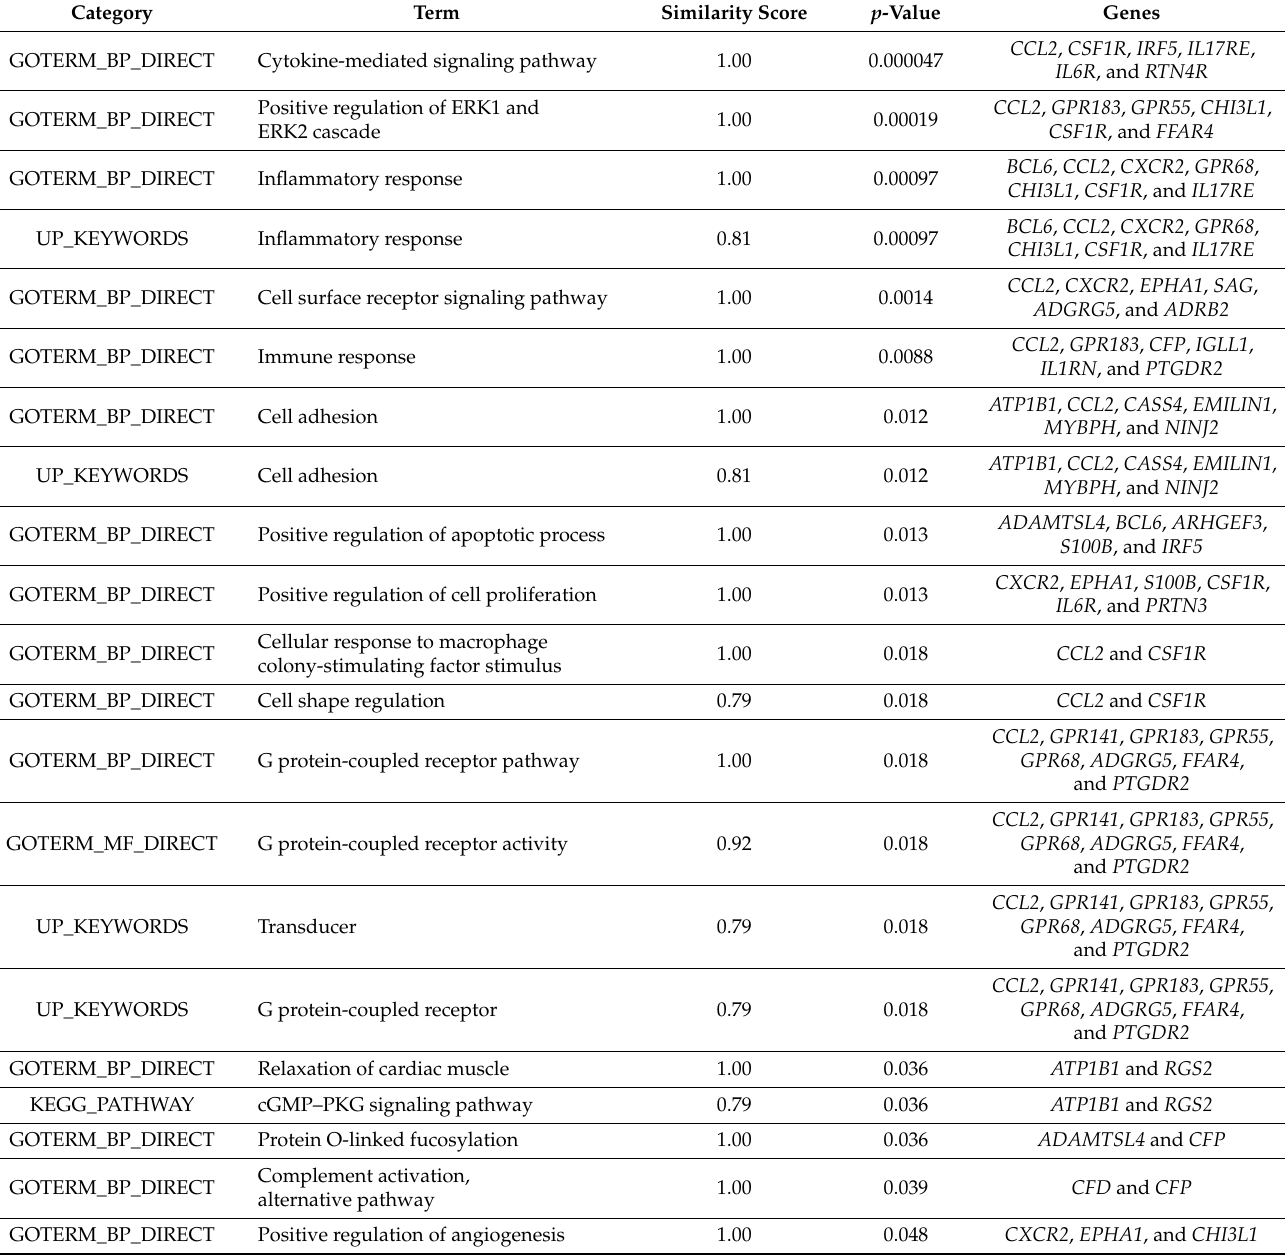
Table 3. Biological process and molecular function of downregulated genes effected by TQ